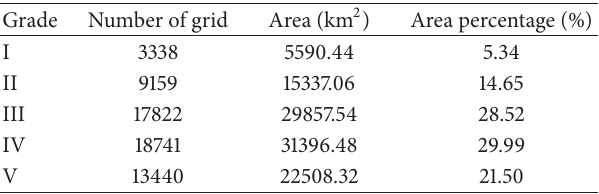
Table 4: The grade proportion of human living environmental evaluation